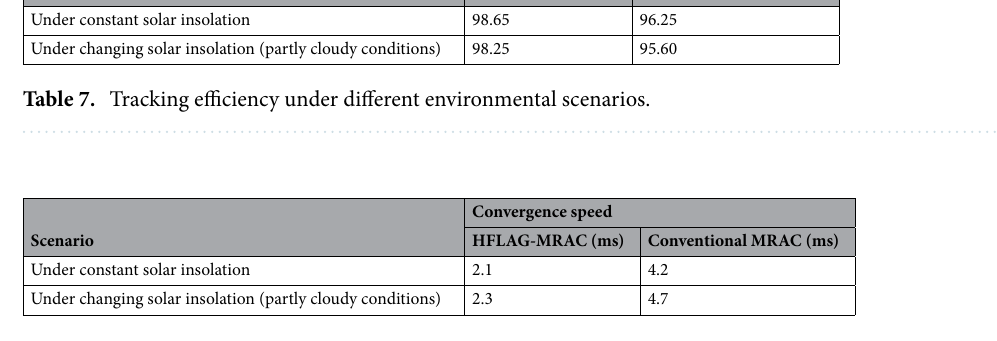
Table 8. Convergence Speed under different environmental